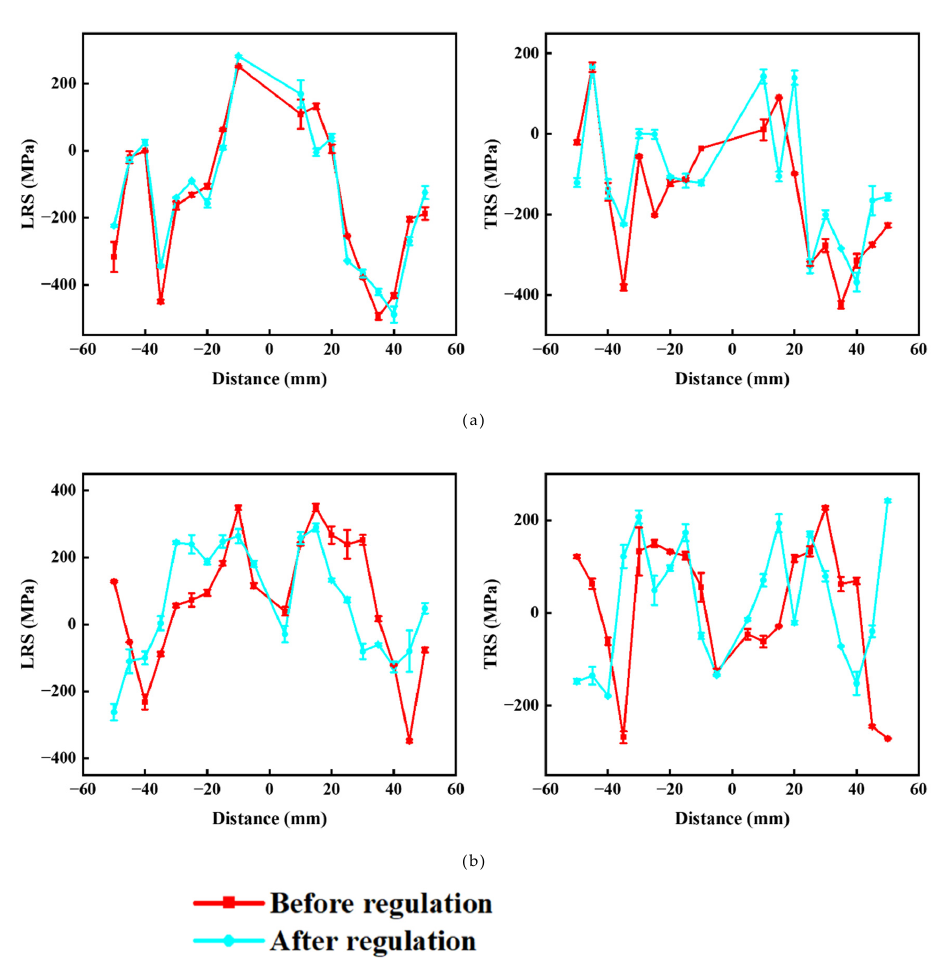
Figure 7. Residual stress distribution of #1 samples before and after treatment. ( a ) Front; ( b ) Back.